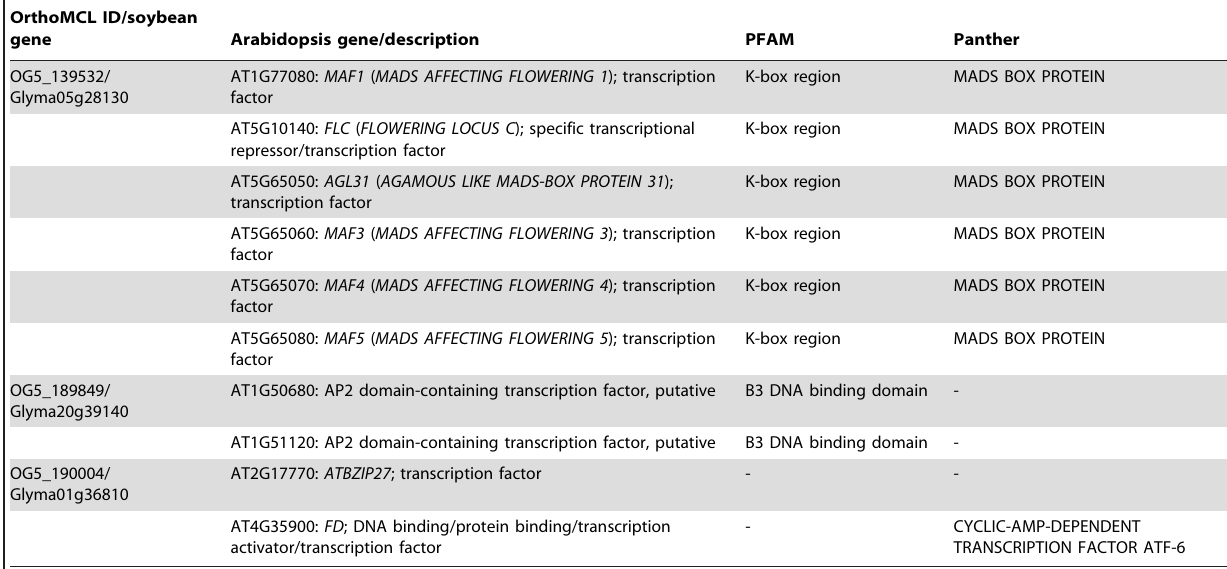
Table 3. List of OGs for flowering genes containing less number of paralogues in soybean.